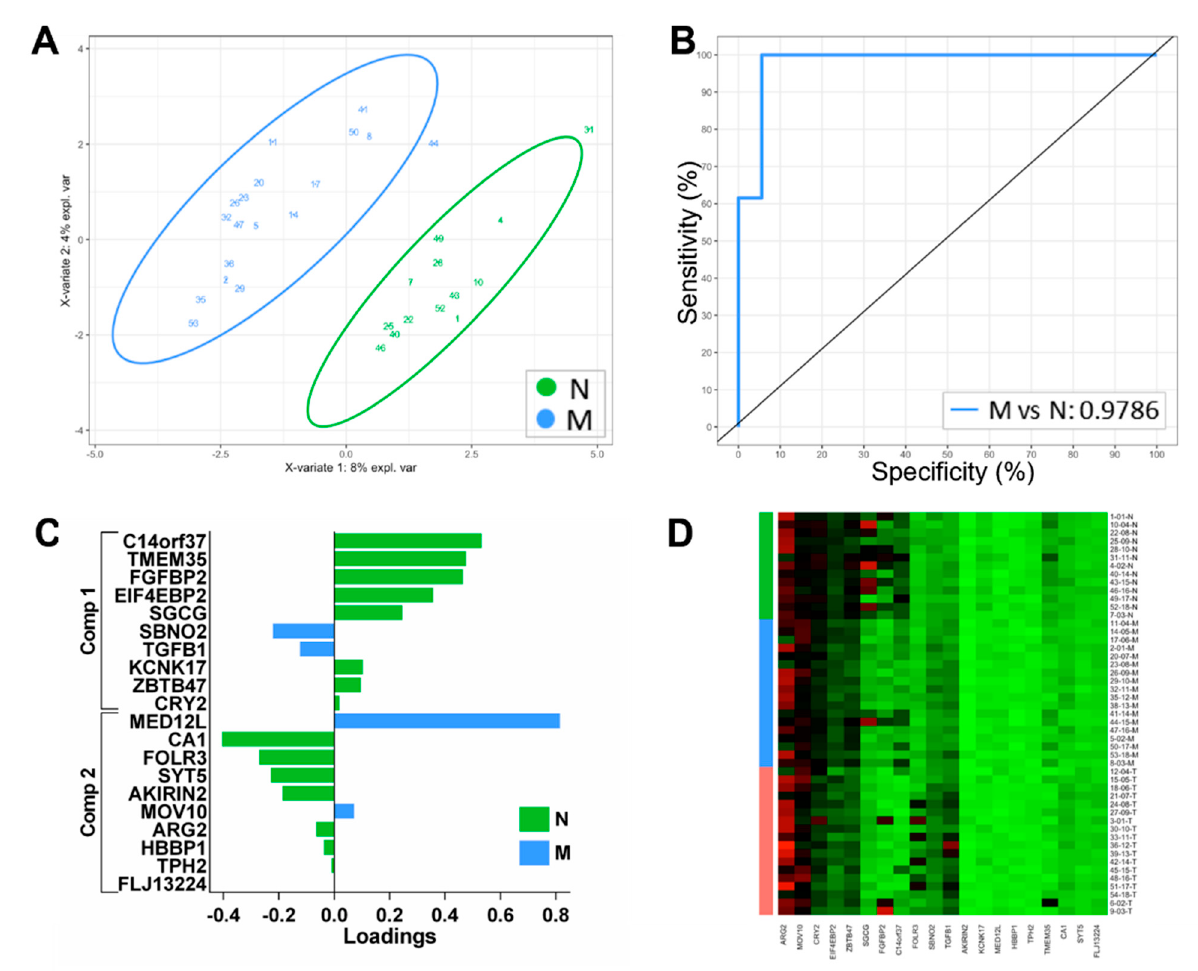
Figure 2. Classification performance sPLS-DA-derived gene expression signatures for binomial comparison: N vs. M. ( A ) Two-dimensional sample plots for the 2 groups with confidence ellipse plots. ( B ) Corresponding ROC curve. ( C ) Loading plots for N vs. M classifiers showing the contribution of each gene to the signature. ( D ) Heatmap of the gene expression across all samples for the N vs. M classifiers.